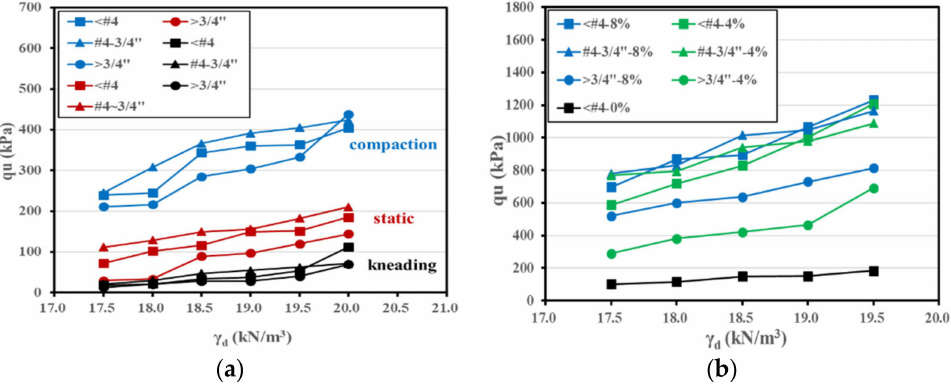
Figure 8. Unconfined compression strength with respect to dry density in soil samples for untreated and treated samples: ( a ) mudstone; ( b )